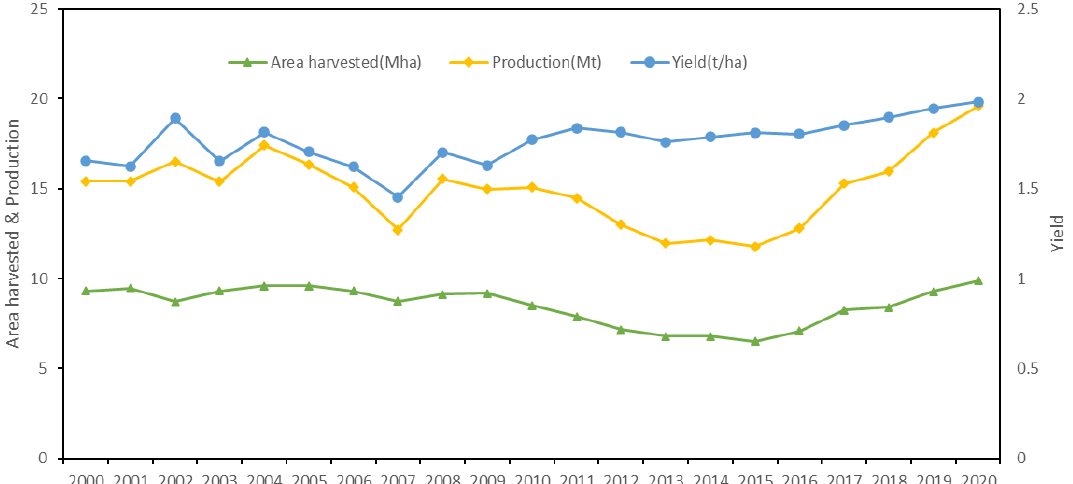
Figure 6. Area harvested, output, and yield of China’s soybeans production from 2000 to 2020 (data source: FAO).